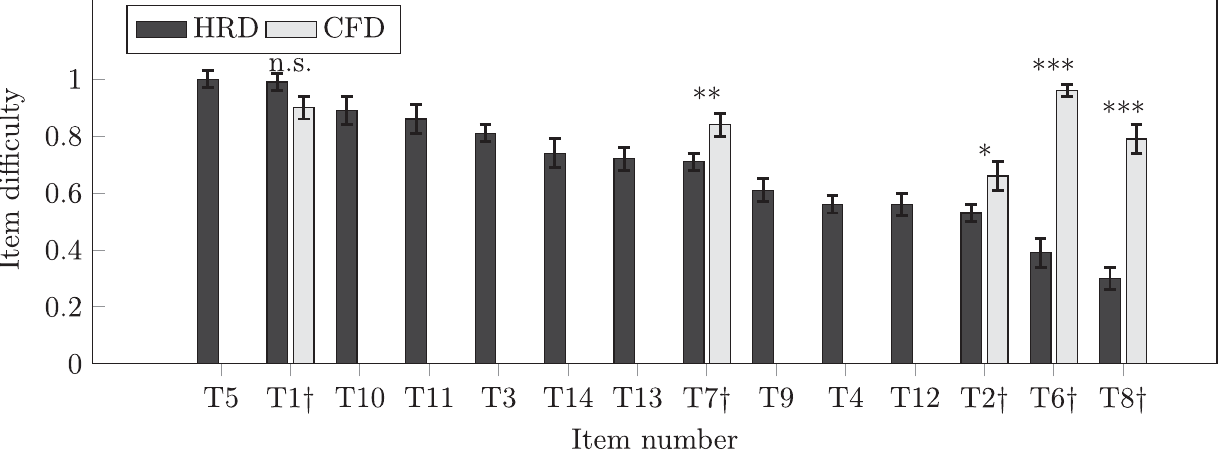
FIG. 6. Histogram of the item difficulties for all items used. The 14 HRD items (T1 – T14) are ordered by item difficulty from easy (left) to difficult (right). For the items marked with the † symbol, there exists an isomorphic item with an x - y diagram. Error bars indicate the standard errors of the mean values.